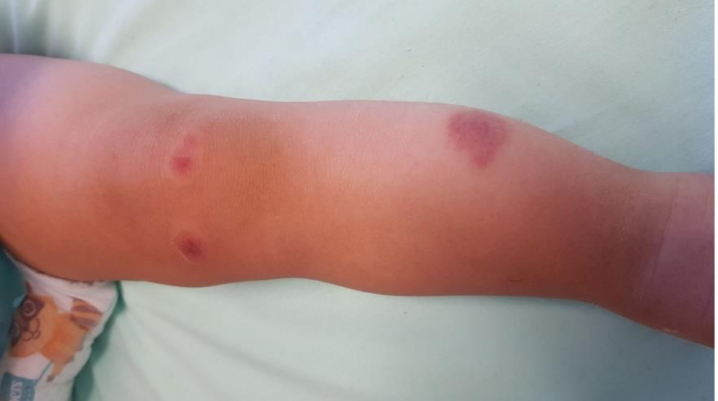
Figure 1. Petechial-hemorrhagic lesions with an oedematous component.